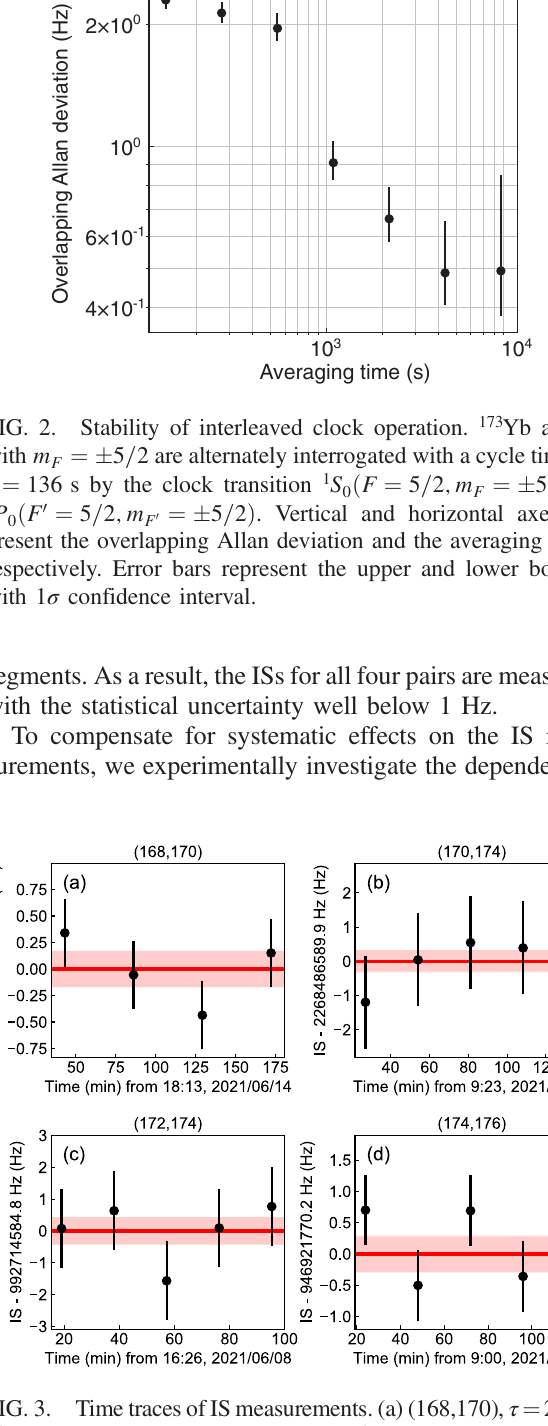
FIG. 3. Time traces of IS measurements. (a) (168,170), τ ¼ 258 s, χ 2 ¼ 1 . 03 , (b) (170,174), τ ¼ 162 s, χ 2 ¼ 0 . 51 , (c) (172,174), red red τ ¼ 170 s, χ 2 ¼ 0 . 75 , and (d) (174,176), τ ¼ 144 s, χ 2 ¼ 1 . 13 . red red represents the reduced χ -squared value. Data points Here, χ 2 red show the mean values of (a) nine measurements and (b) – (d) ten measurements, and error bars represent the overlapping Allan deviations. Red lines and shaded regions correspond to the means of the data points and the 1 σ statistical uncertainties, respectively.